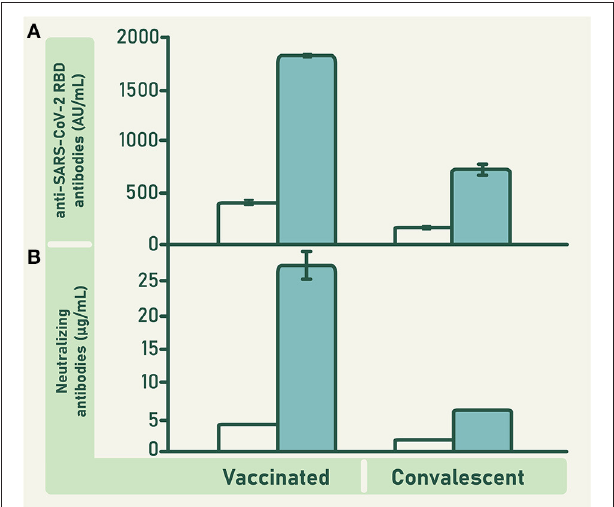
FIGURE 4 | Concentration of anti-RBD antibodies (A) and ACE2-RBD neutralizing antibodies (B) in the pool of plasma collected from vaccinated and convalescent donors (empty bars), and in the VP-IVIg and CP-IVIg (full bars). Bars represent means ± SD of analyzes performed in triplicate. The concentration of anti-RBD antibodies in VP-IVIg and CP-IVIg corresponds to 7902 ± 69 and 3109 ± 199 binding antibody units (BAU)/mL, respectively. The concentration of anti-RBD and ACE2-RBD neutralizing antibodies in CLIA were higher in VP-IVIg and CP-IVIg than in their respective raw plasma ( Figure 4 ). Moreover, the concentration of these antibodies was higher in VP-IVIg than in CP-IVIg ( Figure 4 ).